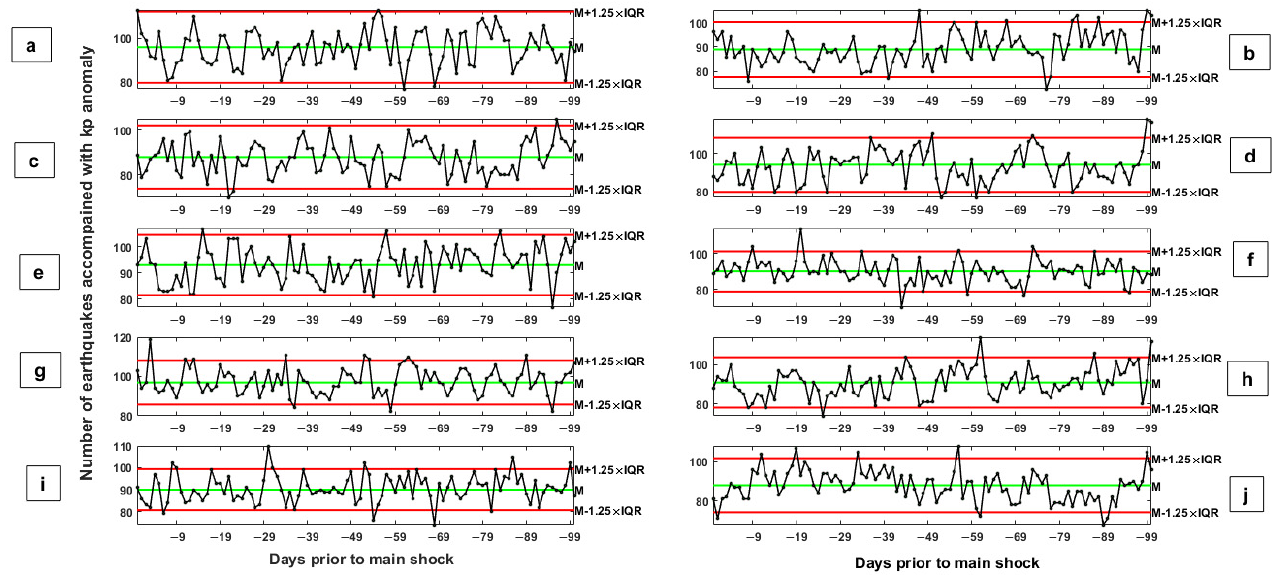
Figure 7. Panels ( a – j ) show the results of 10 simulated earthquakes datasets. The y -axis in each panel indicates the number of simulated earthquakes accompanied by anomalous changes in the K p index during the days prior to the simulated earthquakes. Median and higher and lower bounds are drawn as green and red horizontal lines, respectively. The allowed ranges are defined as M ± 1.25 × IQR , in which M and IQR are the median and the inter-quartile range parameters, respectively.